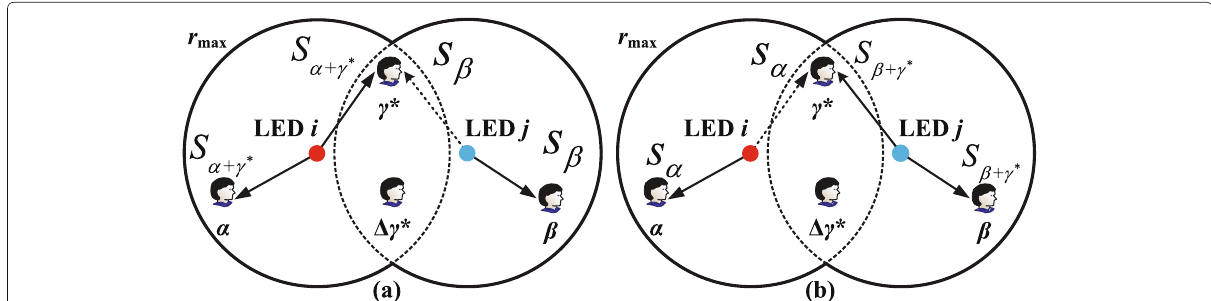
Fig. 2 Edge users within an overlap area in a multi-cell